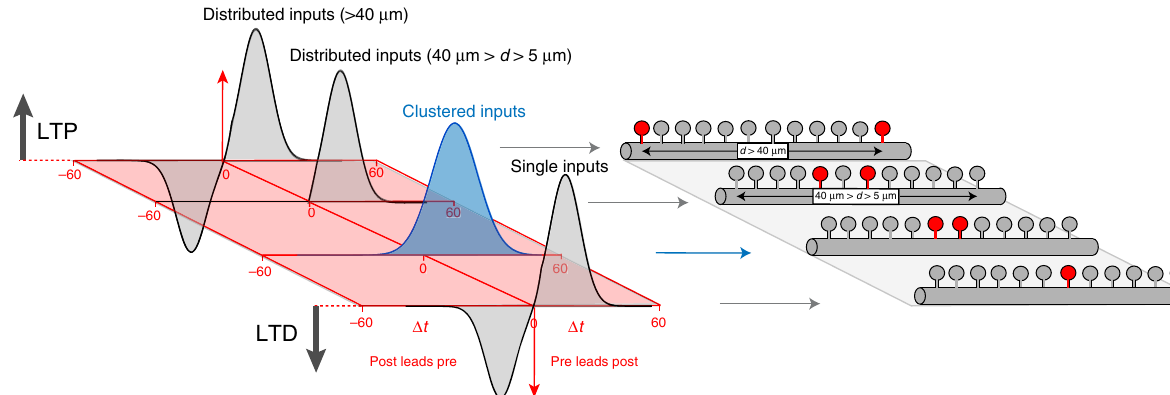
Fig. 9 STDP learning rule for single, distributed, and clustered dendritic spines. STDP learning rule in the basal dendrites of L5 pyramidal neurons as a function of the structural organization of excitatory inputs in basal dendrites of L5 pyramidal neurons. Note how STDP in single, or distributed spines (separated by >40 μ m), follow a bidirectional Hebbian STDP rule. Importantly, our model indicates that the induction of t-LTD can be disrupted by the co- activation of two clustered spines separated by <40 μ m, and that t-LTP is enhanced by the co-activation of two clustered spines separated <5 μ m by synaptic cooperativity. We propose that synaptic cooperativity generates a local dendritic depolarization high enough to disrupt bidirectional STDP, leading to STDP that only encompasses LTP. d